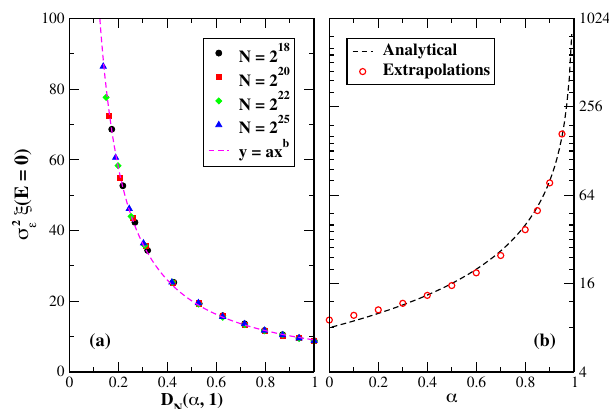
Figure 1. Left panel: Numerical study of the convergence of the localization length to its thermody- namic limit value, i.e. plot of ξ N ( E = 0) /ξ as a function of N /ξ for the 1D Anderson model with ∞ ∞ Figure 2. (a) Plot of the normalized localization length, σ 2 ε ξ ( E = 0), as a function of the parameter open boundaries. The data were computed using the KPM with M = 2048 Chebyshev moments and D N ( α, 1), for the de Moura-Lyra model with OBC at zero temperature. The numerical computations have an estimated error of 1%. The parameter ξ is the analytically calculated localization length in ∞ were carried out for a disorder variance σ ε = 0 . 289 using M = 2048 Chebyshev moments and an the perturbative regime for N [8]. In the inset, we confirm the convergence of the KPM estimates → ∞ estimated error of 1%. The data can be collapsed into a single curve y = ax b (dashed magenta line). (b) of the localization length by comparing with the results calculated by an exact diagonalization of the Comparison between the thermodynamic limit values of σ 2 ε ξ ( E = 0) predicted by the dashed curve in disordered Hamiltonian for W / t = 1. (b), with the analytical expression of Eq. Right panel: Estimates of the normalized localization length σ 2 ε ξ ( E = 0), as a function of α for the de Moura-Lyra model with OBC using the KPM. The computations were carried out for a fixed (a) system of size of N = 2 18 sites and various local variances, σ ε , and (b) σ ε = 0 . 289 (i.e. W = t ) and for various system sizes. Once again, M = 2048 Chebyshev moments were used to obtain an 1% estimated error of convergence. The dashed black curve stands for the Izrailev-Krokhin result (Eq.(7)) and, in (b) , the numerical curves seem to be converging towards this one as N is increased. This reflects the strong finite-size e ff ects which are known to exist in this problem.